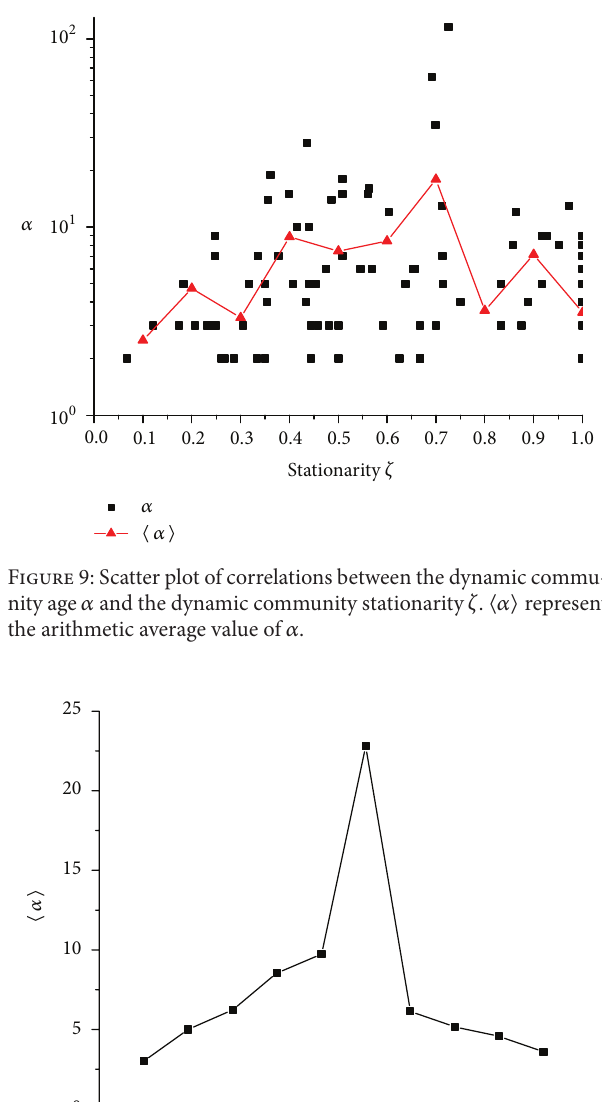
Figure 8: Scatter plot of correlations between the dynamic commu- nity age 𝛼 and the start size 𝑠 of a dynamic community.